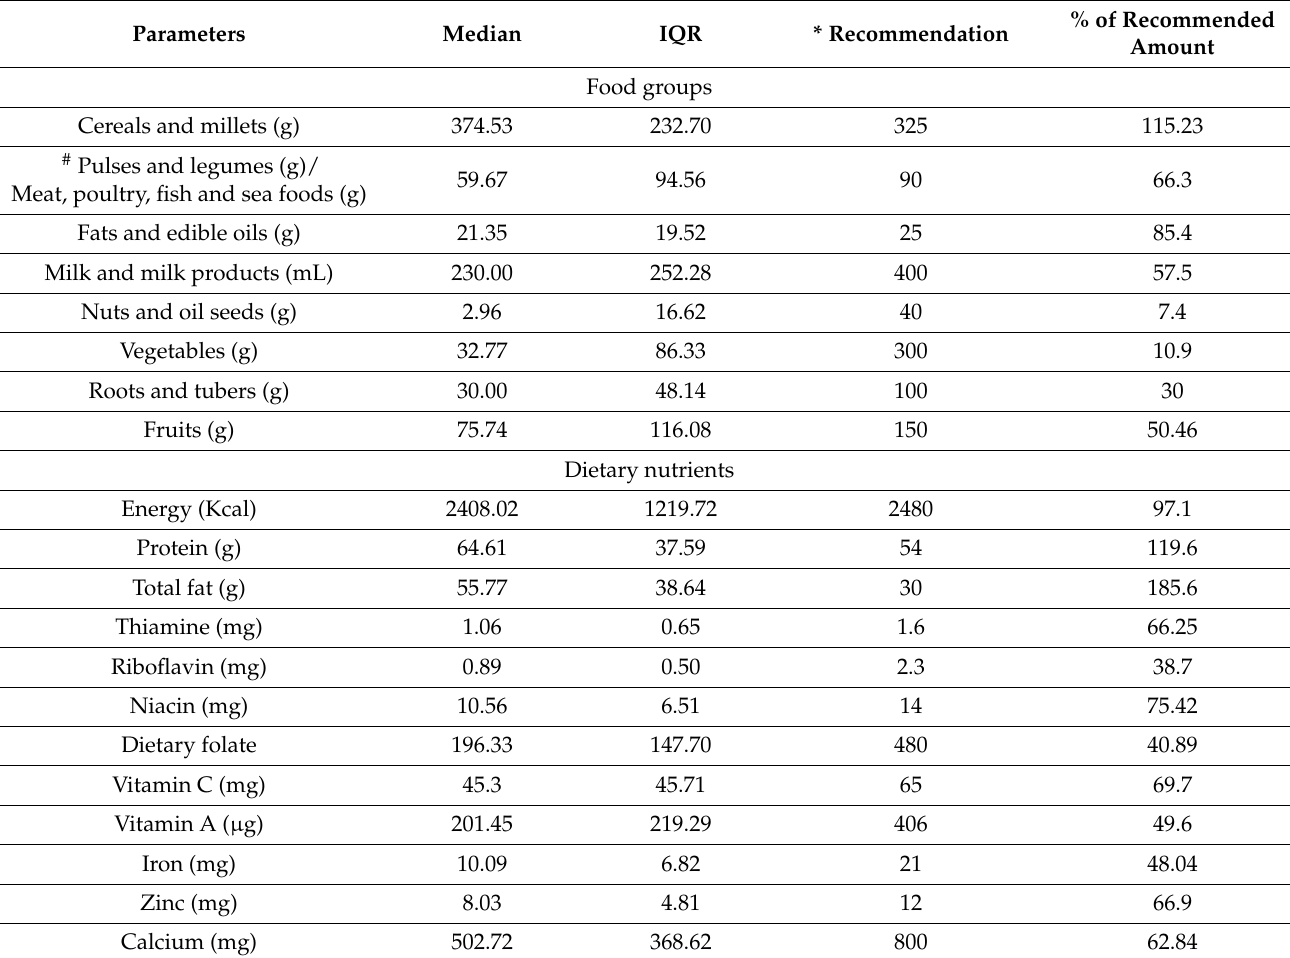
Table 3. Median intake of food groups and nutrients among pregnant women based on % of balanced diet requirement for the Indian